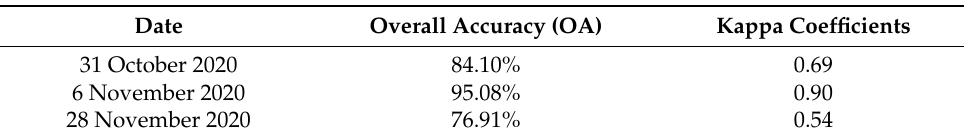
Table 2. The classification accuracy of the 31 October, 6 November, and 28 November 2020 moonlight images.